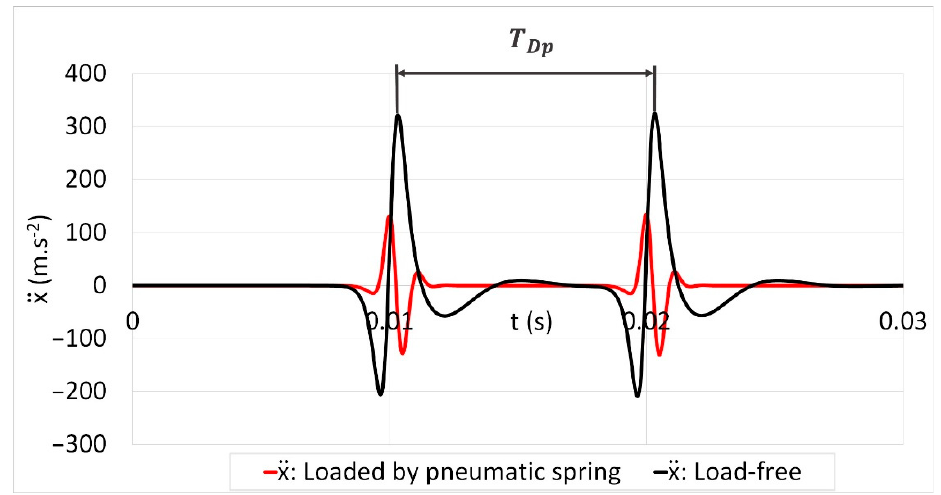
Figure 19. The time relation of mass acceleration—the influence of the external force.